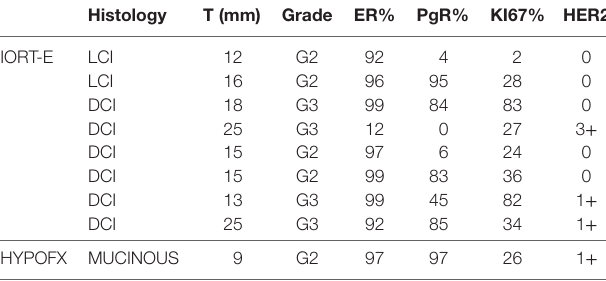
FigUre 1 | Kaplan–Meier estimates of the cumulative probability of ipsilateral TaBle 2 | Characteristics of patients who developed ipsilateral breast tumor recurrences (IBRT) in intraoperative radiation therapy with an electron beam (IORT-E) group and in HYPOFX group.